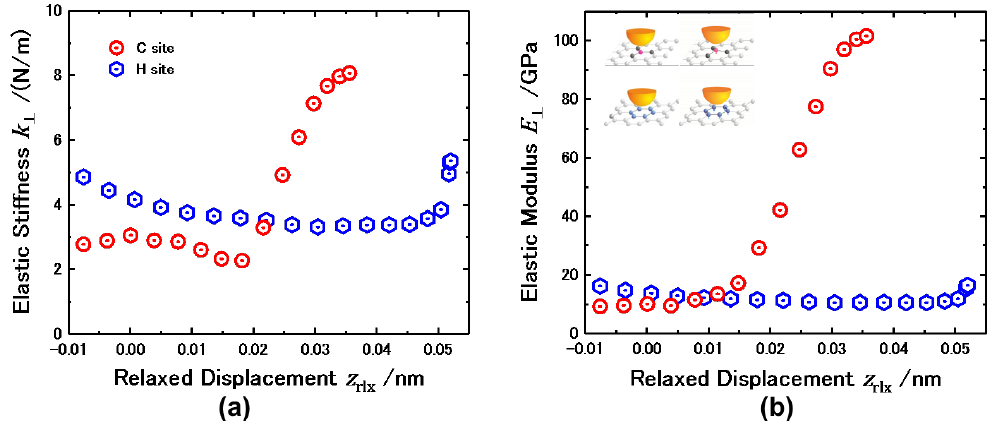
Figure 4. Quantitative relationship of ( a ) out-of-plane elastic stiffness 𝑘 ⊥ and ( b ) elastic modulus 𝐸 ⊥ at the atomically specific C and H sites of the convexly curved graphene with the relaxed displacement z rlx in the vertical direction due to tip-sample attractive interaction. The effective area of the interatomic forces acting between the tip-apex atom and the C and H sites are schematically illustrated in the inset of